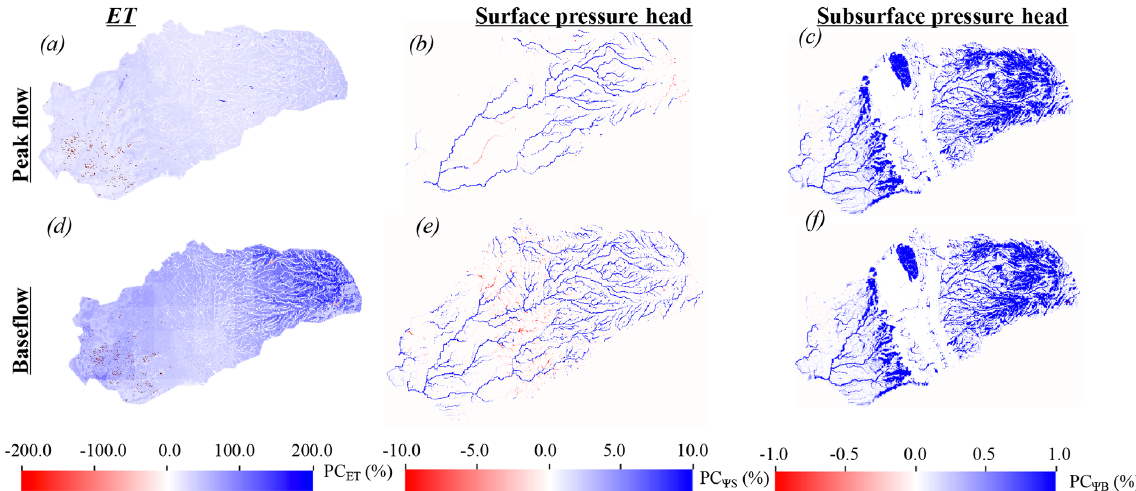
Figure 7. Comparisons between EoC dry water year (WY) and the historical dry WY peak flow and baseflow spatial distributions of percent ) pressure heads. Regions in red correspond to areas with smaller fluxes changes in ET (PC ET ), surface water (PC (cid:57) ), and subsurface (PC (cid:57) B S or pressure heads in the EoC compared to the historical ones, whereas regions in blue correspond to areas with larger fluxes or pressure heads in the EoC compared to the historical